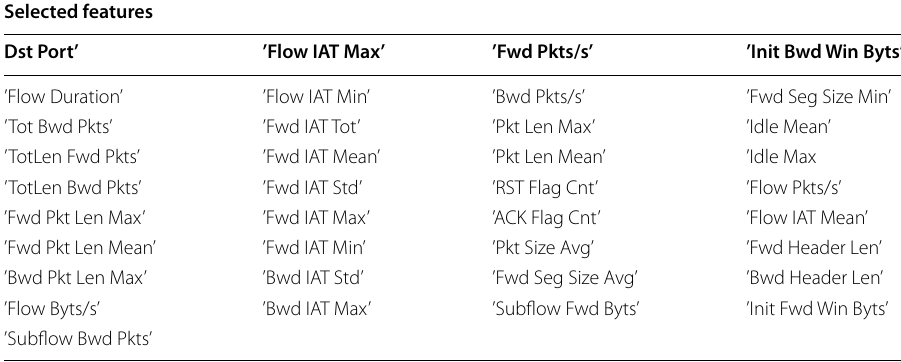
Table 5 Selected features using Random Forests feature selection in the CIC-IDS 2018 Dataset Selected